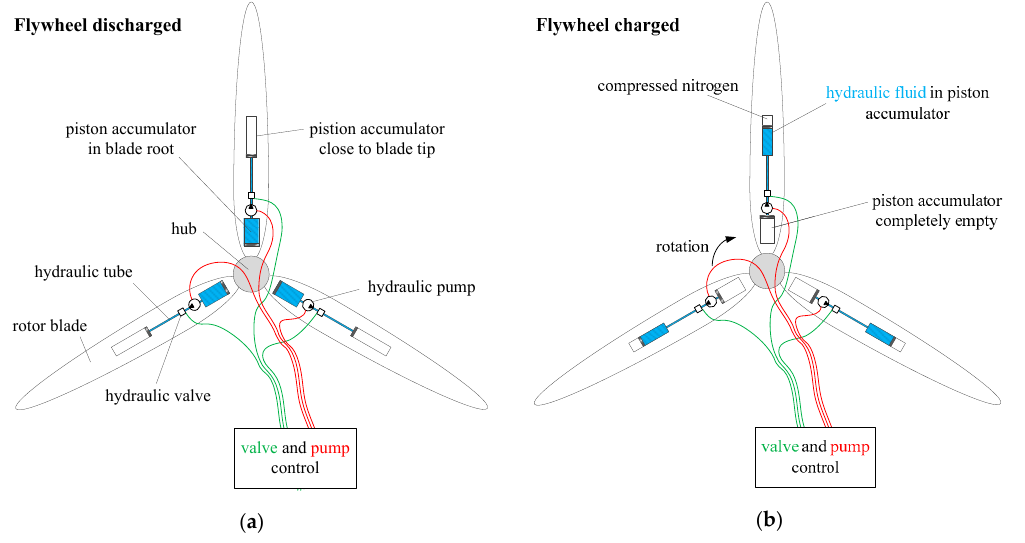
Figure 1. Simplified sketch of the flywheel (FW) system: ( a ) flywheel in discharged state and ( b ) flywheel in charged state.